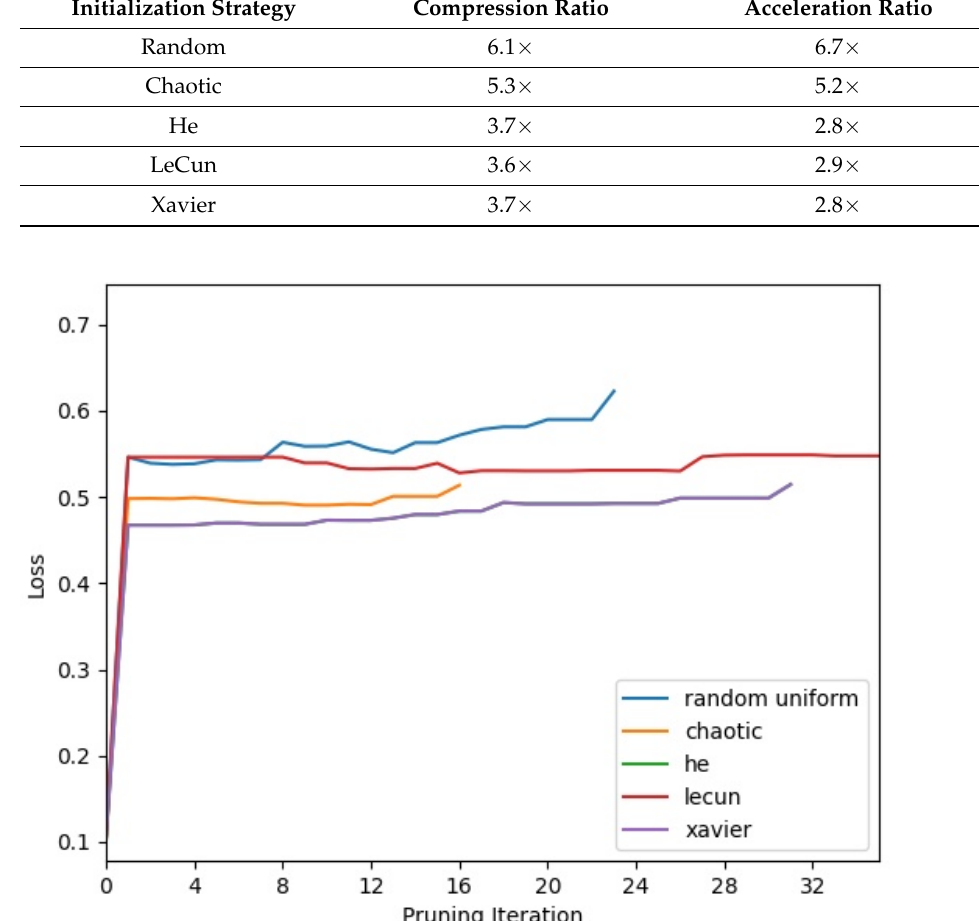
Figure 3. Convergence curve of the proposed approach with different weight initialization strategies. We report the loss of the network just after pruning (and before fine-tuning).